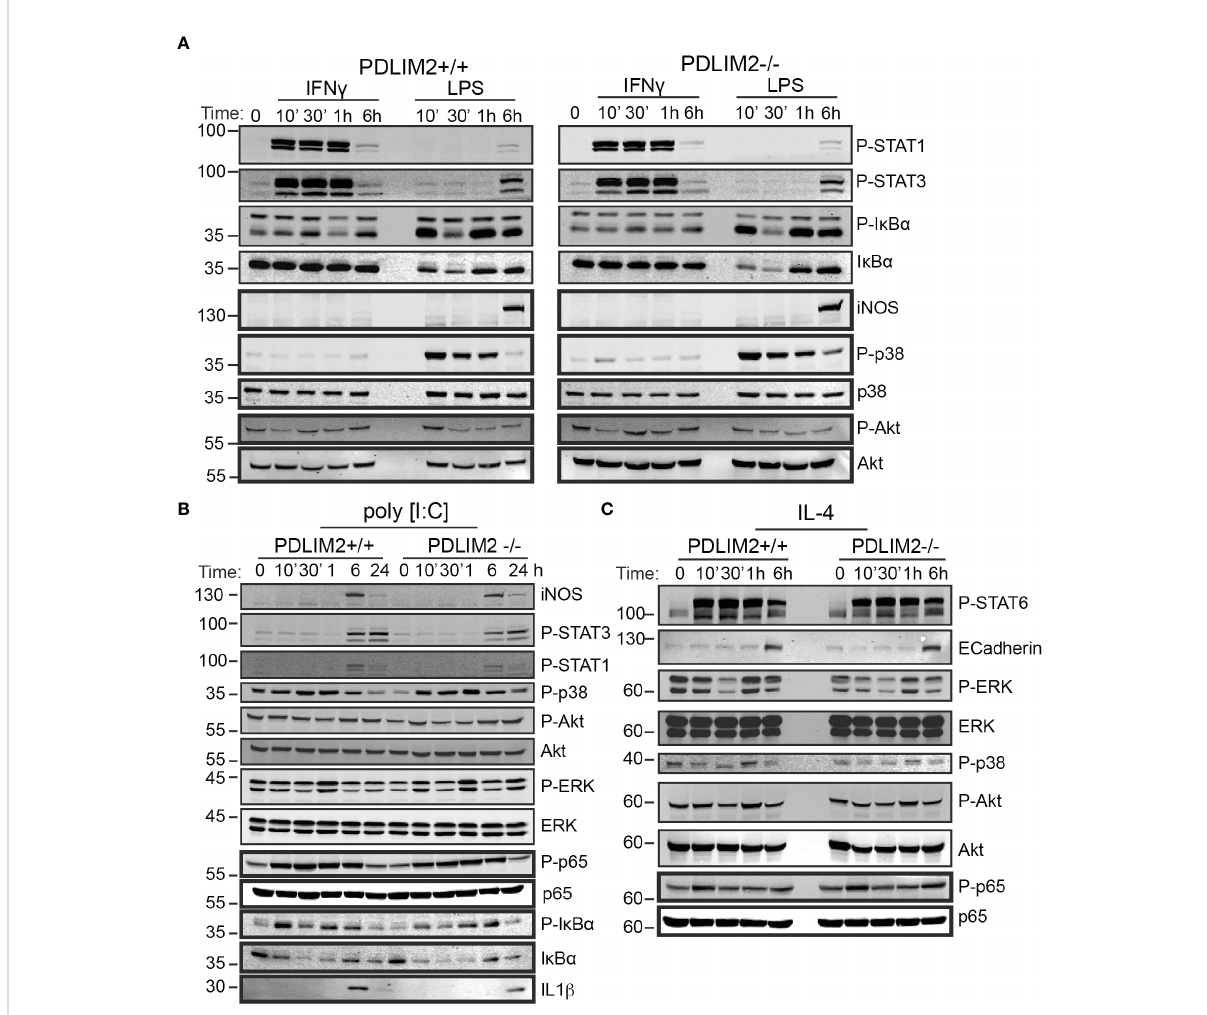
FIGURE 5 PDLIM2 is not required for activation of signalling downstream from M1 or M2 polarization receptors, including activation of STATs and NFkB- P65 in BMDM. (A – C) : Cell lysates from PDLIM2+/+ and -/- BMDM were cultured with IFN g , or LPS (A) or PolyI:C (B) or IL-4 (C) , for the indicated times and cell lysates were prepared for western blotting with speci fi c antibodies for the indicated proteins or phospho-proteins. The approximate protein size in KDa is shown on the left of